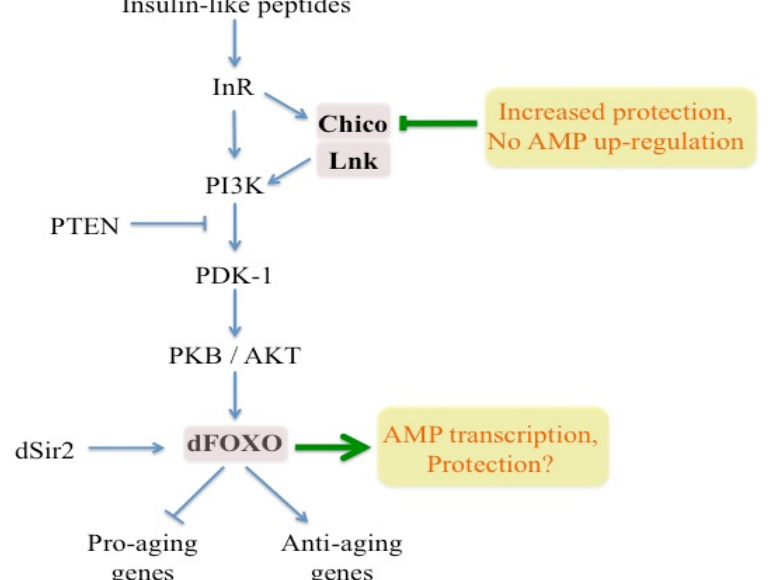
Figure 1. Interaction between the insulin/Igf-like (IIS) signaling pathway with immune function and pathogen resistance in Drosophila . Insulin Receptor (InR) is initially activated upon binding of insulin-like peptides. The activated receptor either phosphorylates directly the enzyme phosphoinositide 3-kinase (PI3K) or acts indirectly through the insulin receptor substrate proteins Chico and Lnk. PI3K is a lipid kinase consisting of the regulatory subunit dP60 and the catalytic subunit dP110. PI3K is then recruited to the membrane where it phosphorylates the 3' position of phosphatidylinositol-(4,5)-bisphosphate (PIP ) and thereby generates 2 phosphatidylinositol-(3,4,5)-trisphosphate (PIP ). Elevated levels of PIP recruit the 3 3 PH-domain-containing protein kinase B (PKB/AKT) to the plasma membrane, facilitating its activation by phosphoinositide-dependent kinase 1 (PDK1). PKB signals downstream by inhibiting the FOXO (forkhead box, subgroup “O”) family of transcription factors ( dFOXO in Drosophila ). Inhibition of the IIS pathway allows dFOXO to negatively regulate the expression of pro-aging genes and positively regulate the expression of anti- aging genes. PTEN is a negative regulator of the IIS pathway. It is not currently clear whether overexpression of Silent information regulator 2 ( Sir2 or Sirtuin ) increases longevity in Drosophila . Chico mutant flies have improved survival after bacterial infection that is not due to AMP up-regulation. Transcription factor dFOXO regulates antimicrobial peptide (AMP) transcription but its activation does not protect flies against pathogenic